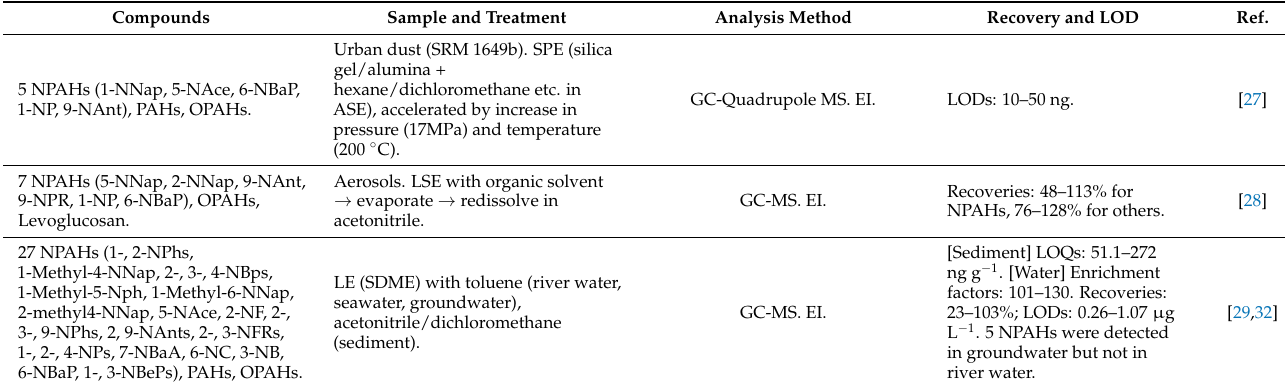
Table 1. Typical sample treatment methods in the analyses of